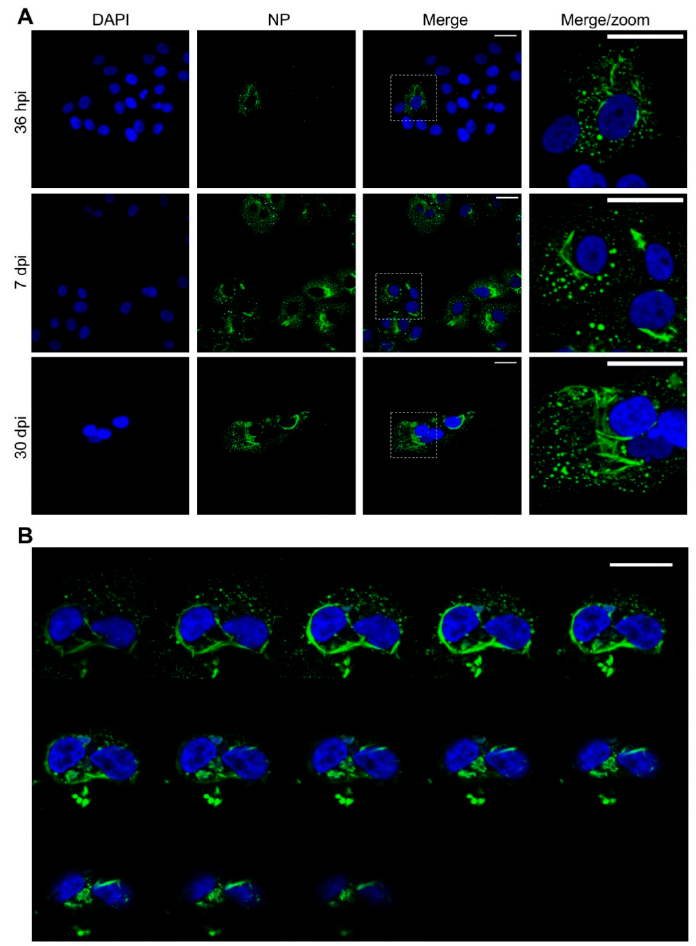
Figure 1. Confocal images showing the characteristic morphology of Tula virus (TULV) nucleocapsid protein (NP) -stained structures at early, peak and persistent stages of TULV infection in Vero E6 cells. ( A ) Vero E6 cells were infected with TULV at a multiplicity of infection of 0.1, and the images were taken at 36 h post infection (hpi), 7 days post infection (dpi) and 30 dpi using 40 × magnification. Nuclei were stained with DAPI (blue) and TULV NP, detected using NP antisera (green), revealing the characteristic NP punctate and filamentous / tubular structures in the perinuclear region. ( B ) Successive Z sections of TULV-infected cells at 30 dpi show NP filamentous / tubular structures extending around the nucleus. The scale bars represent 30 µm.